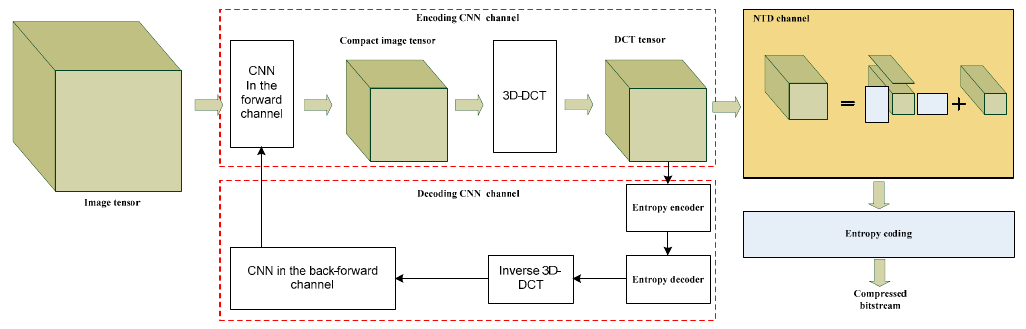
Figure 4. Overall architecture of the compression scheme using the CNNs in conjunction with NTD.